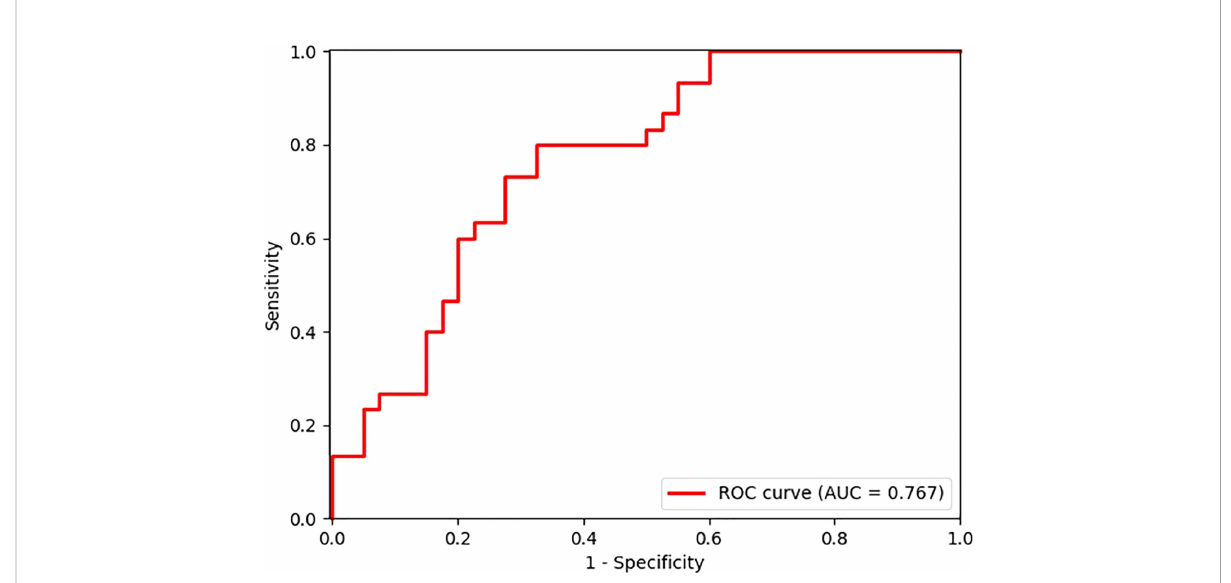
FIGURE 5 Receiver operating characteristic (ROC) curve of the model performance using the hold-out test